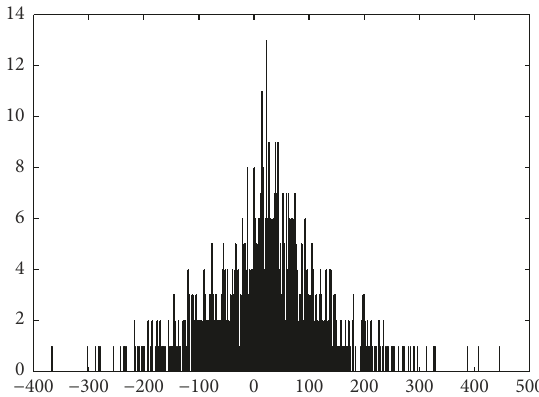
Figure 2: The distribution of the 𝐸 values for the clip track 1 .